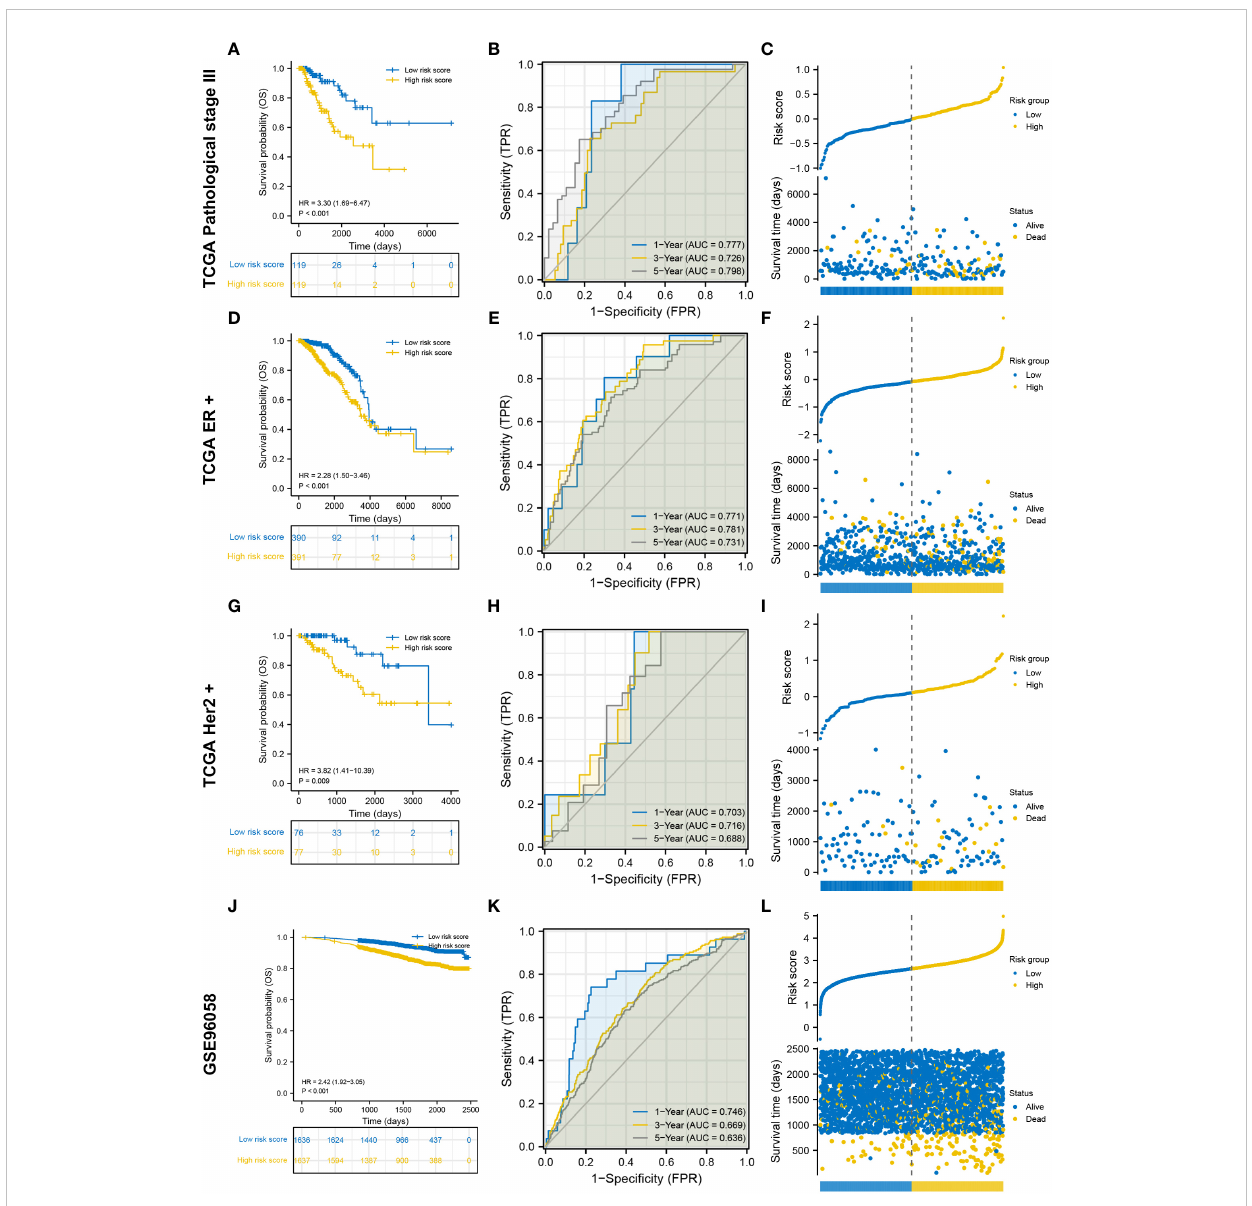
FIGURE 3 Internal and external validation of the degradome signature. (A – C) Internal validation based on TCGA pathological stage III cohort. (D – F) Internal validation based on TCGA ER-positive cohort. (G – I) Internal validation based on TCGA HER2-positive cohort. (J – L) External validation based on GSE96058